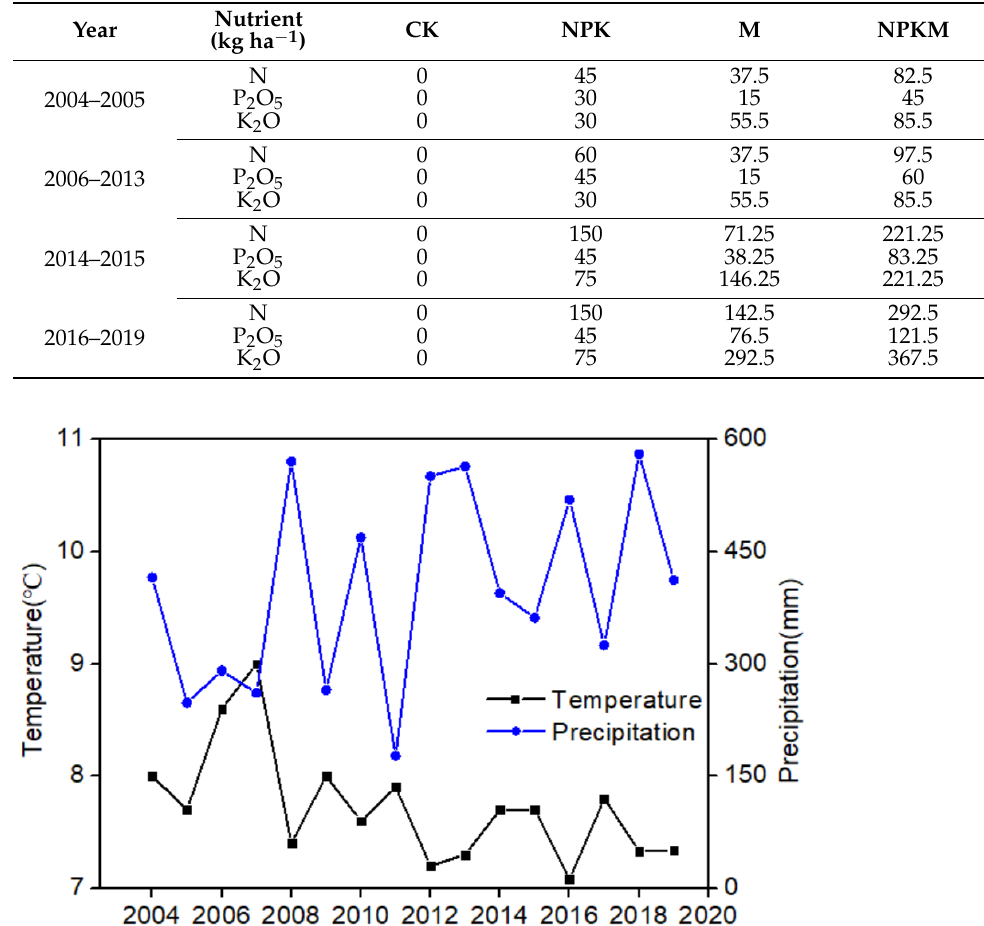
Table A1. The amount of fertilizer applied under different treatments (kg ha − 1 ).